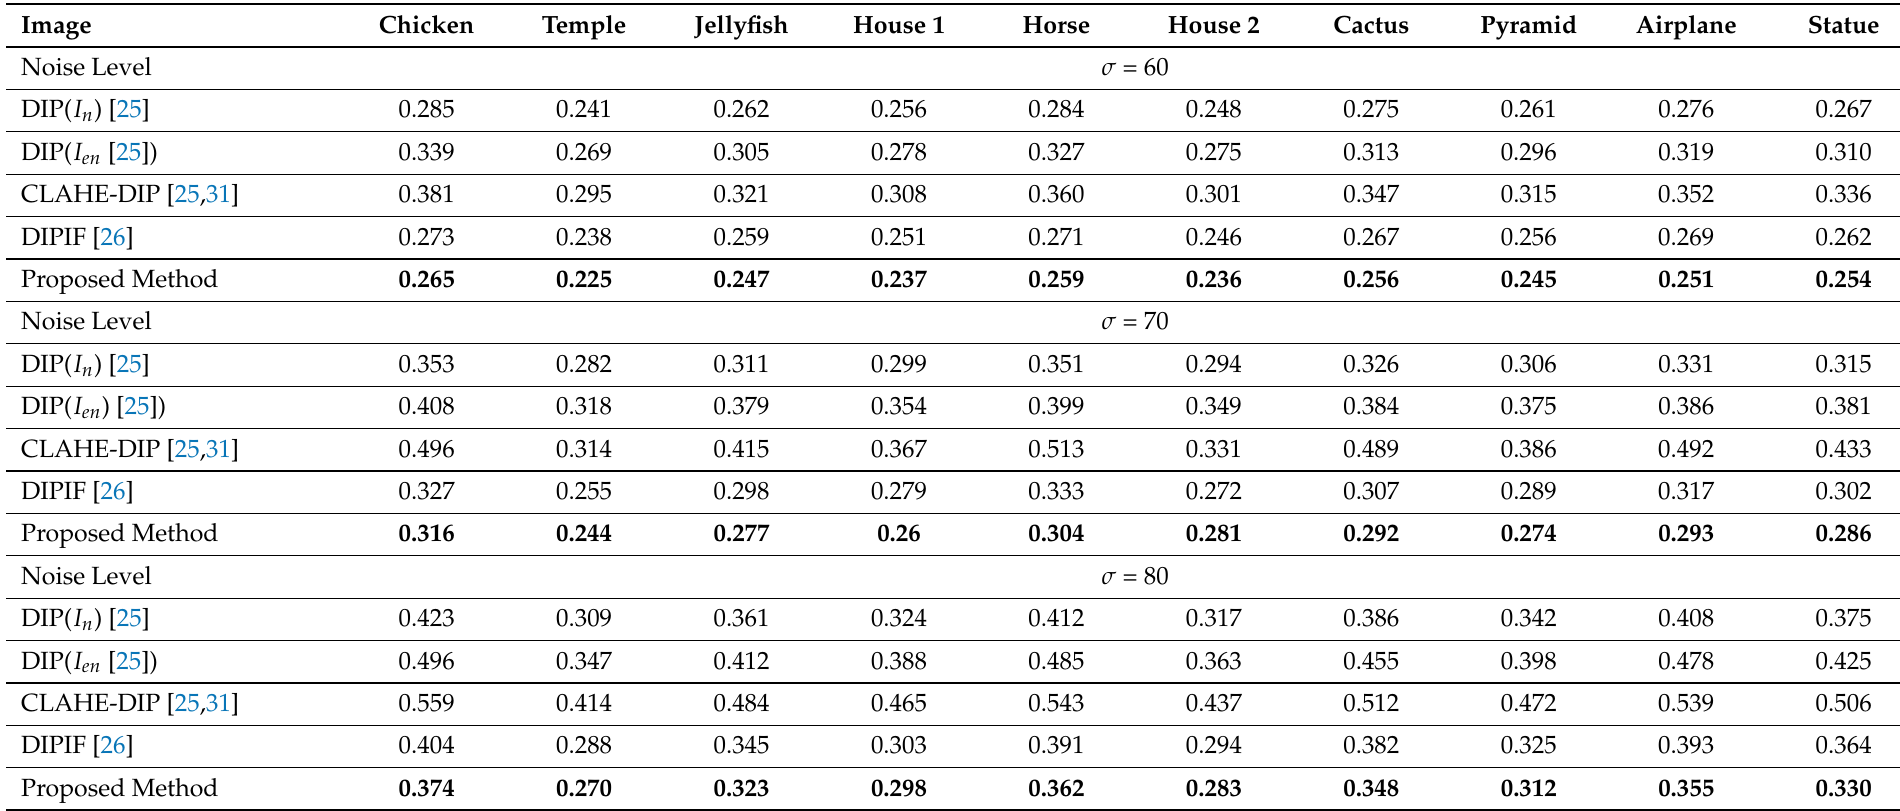
Table 3. The LPIPS values of our proposed method and the competitive denoising methods on 10 randomly selected test images. Note that a smaller value of LPIPS implies a better result in